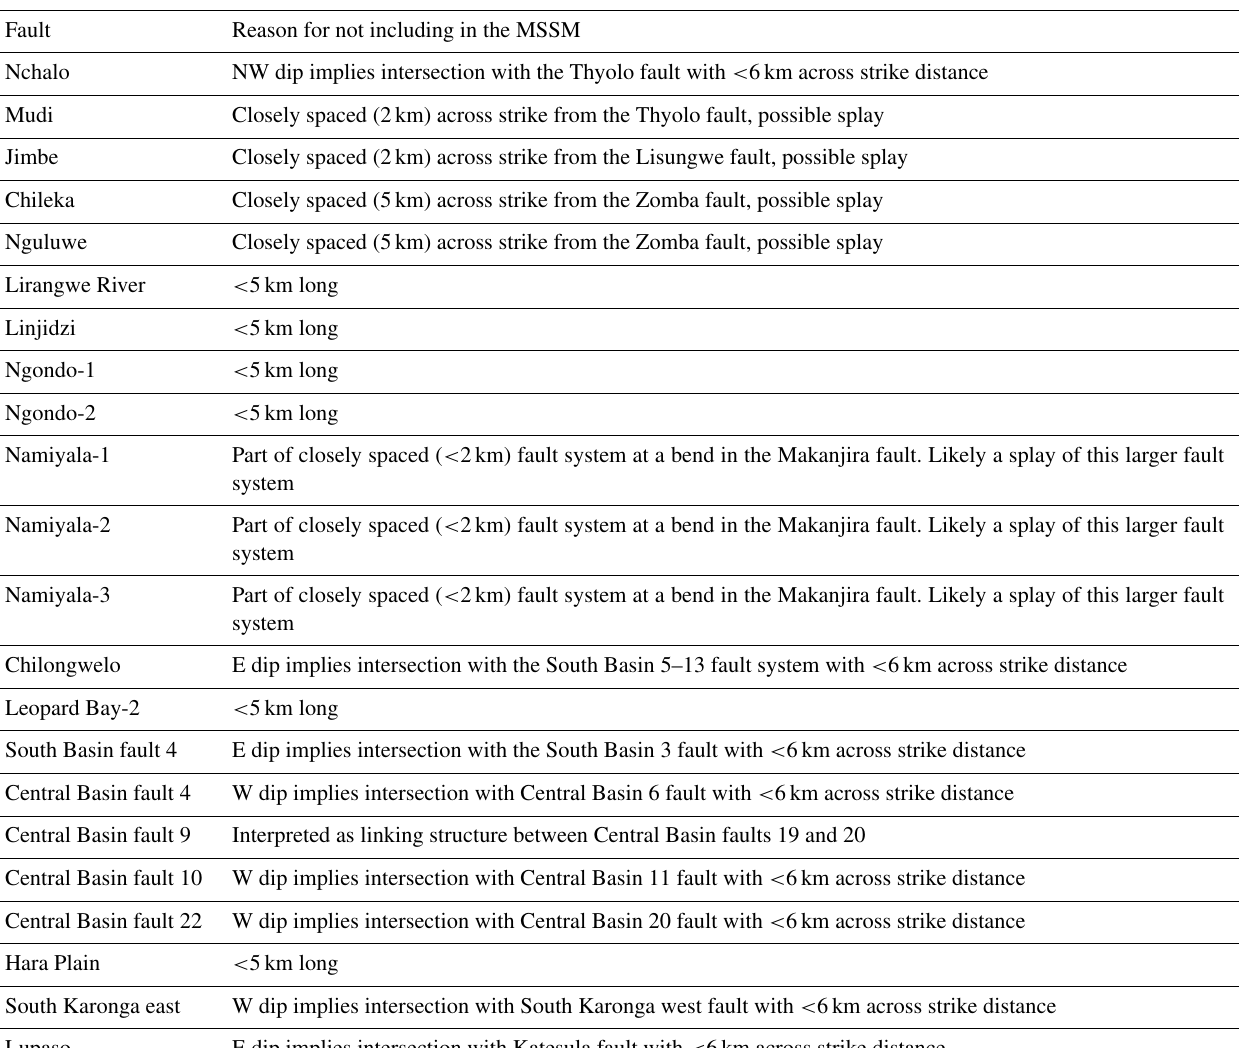
Table A1. List of faults that are included in the Malawi Active Fault Database (MAFD; Williams et al., 2022b) but not the Malawi Seismo- genic Source Model (MSSM). The reason for their removal from the MSSM is also